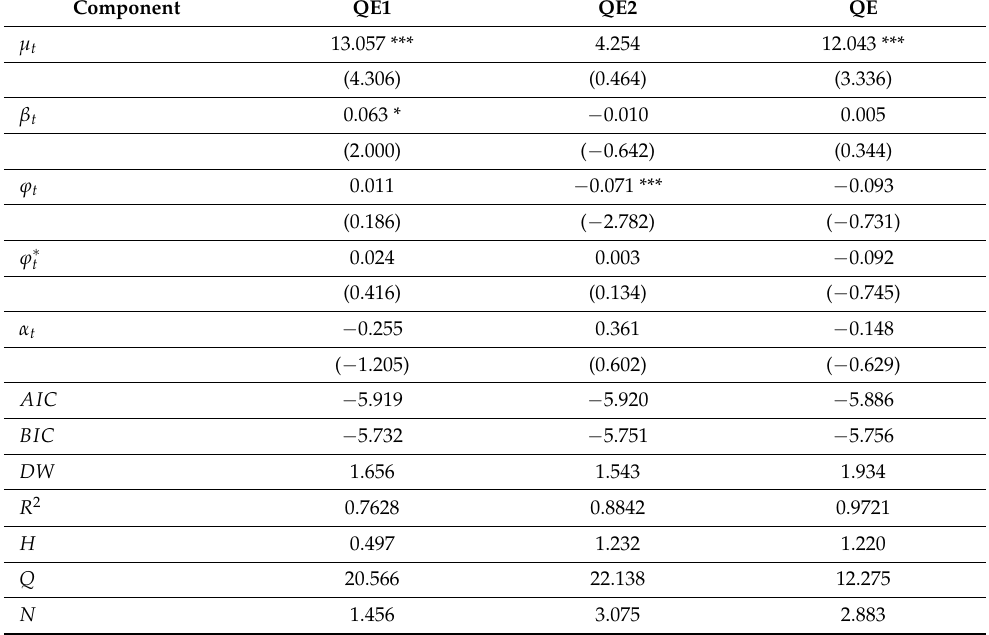
Table 4. Results of Estimating the Model for the Bank of